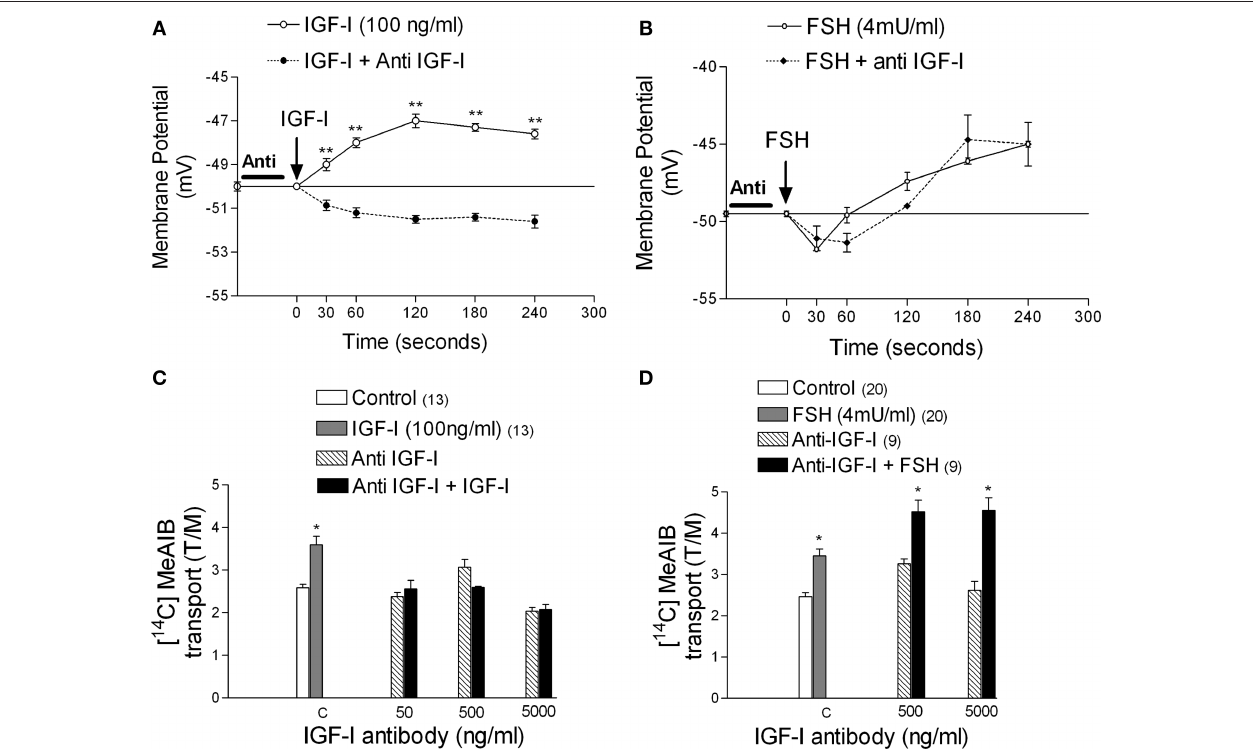
FiGure 8 | effect of anti-iGF-i antibody (500 ng/ml) on the action of iGF-i and FSH on membrane potential and [ 14 C]-MeAiB transport. The anti-IGF-I antibody inhibited the depolarization produced by IGF-I on MP (A) but it did not interfere with the MP modifications produced by FSH (B) . The antibody inhibited the action of IGF-I on [ 14 C]-MeAIB transport at all concentrations tested (C) but did not inhibit